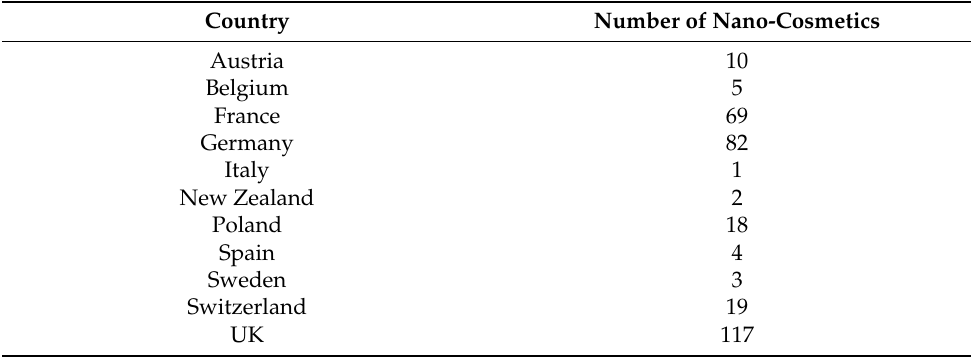
Table 7. Nano-cosmetics commercially available in European countries. Country